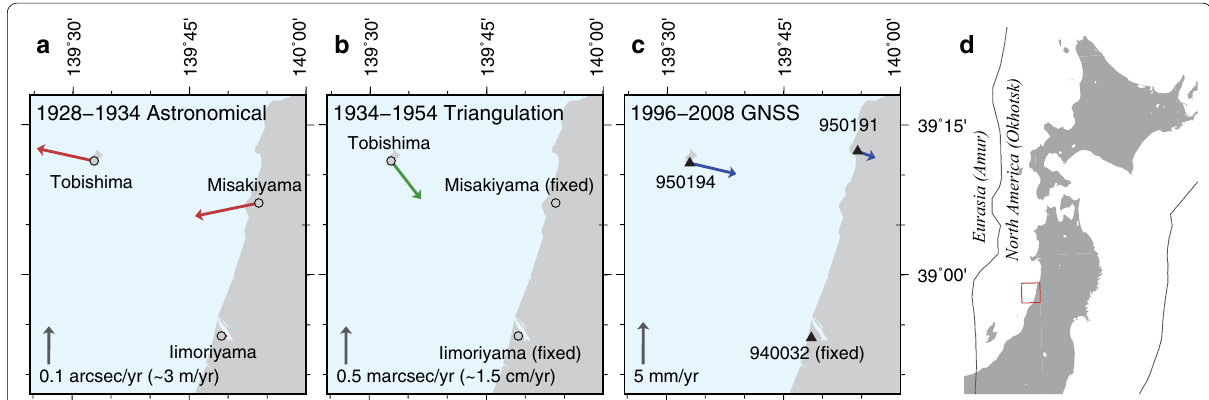
Fig. 7 Movement of Tobishima measured by three different techniques. a Displacement of the Tobishima station and the two mainland stations inferred by two astronomical measurements of latitudes and longitudes conducted in 1928 and 1934 (Miyaji 1935). b Displacement of Tobishima by triangulation in 1934 and 1954 (Okuda et al. 1955). c Velocity vectors of the nearby three GNSS stations during 1996–2008 by GNSS (mekira.gsi. go.jp). The location of the maps in a – c is shown with a red square in d . The eastern margin of the Sea of Japan is considered to be a part of the boundary between the Eurasian (Amurian) and the North American (Okhotsk) Plates